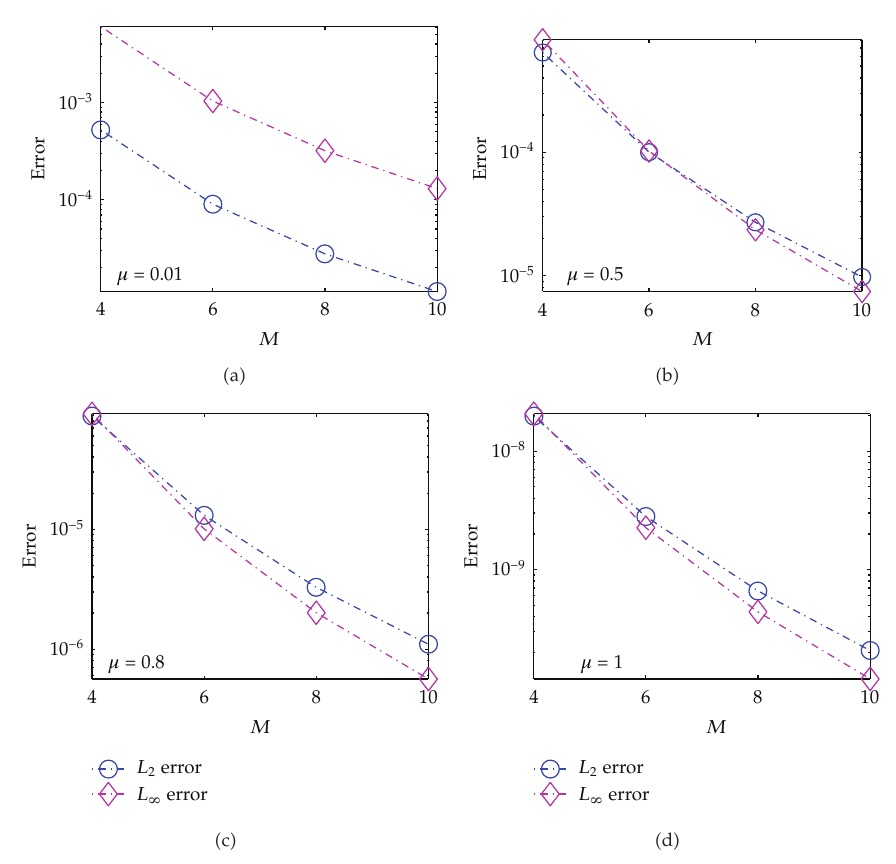
Figure 9: y -axis is log scale. Errors versus M with N (cid:6) 16 for several μ